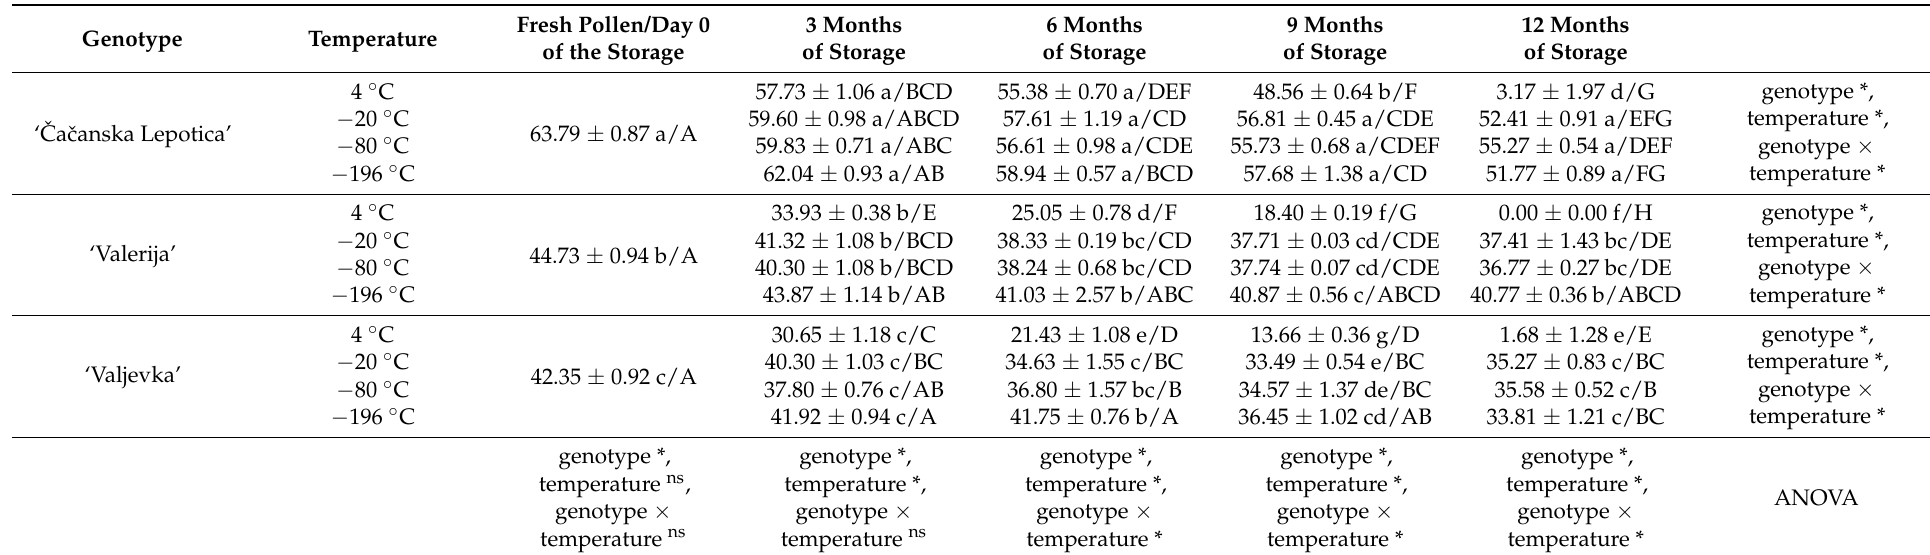
Table 2. In vitro pollen germination stored at different temperatures for different